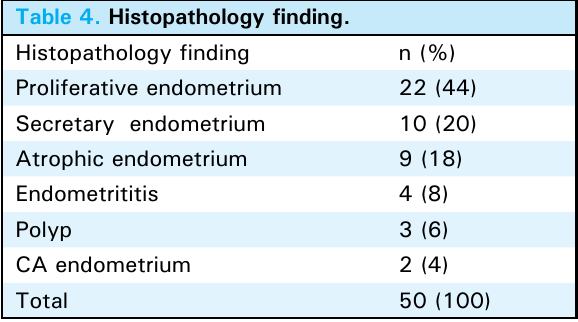
table 4. Histopathology